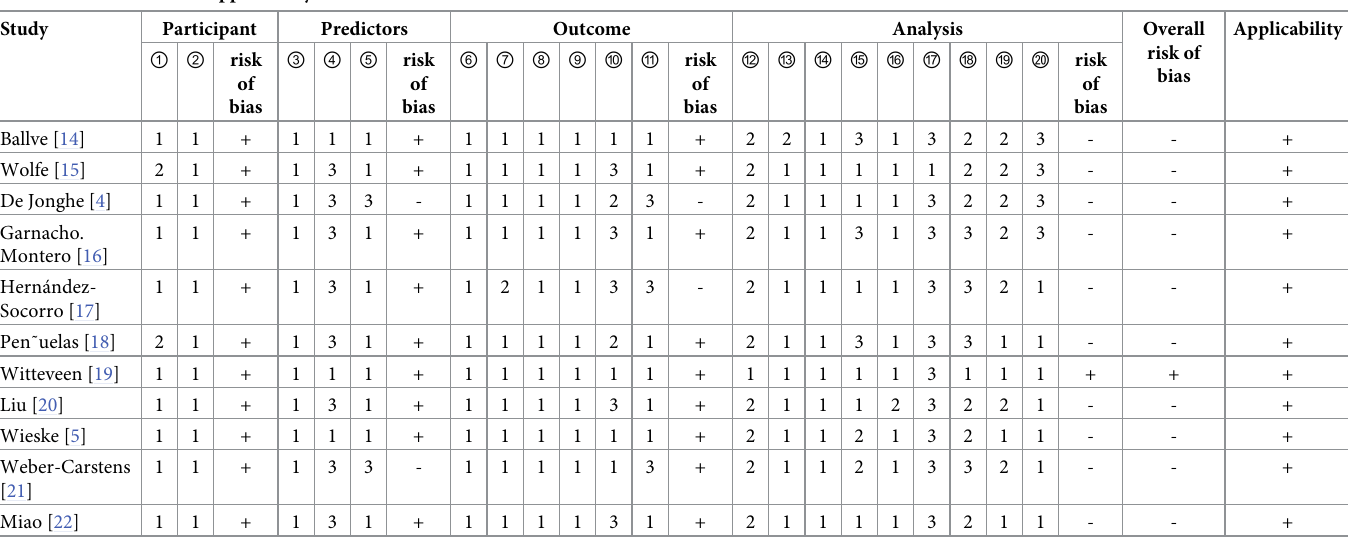
Table 4. Risk of bias and applicability evaluation of